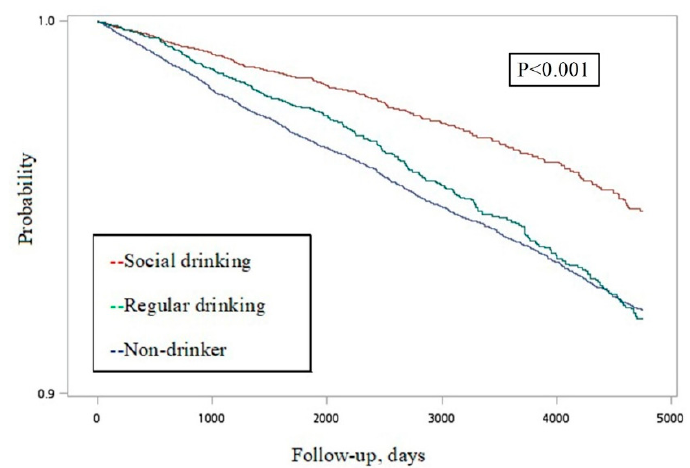
Figure 1. Kaplan–Meier survival curve estimates for incident chronic kidney disease in a random community sample from Taiwan.